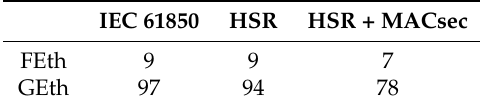
Table 3. Maximum number of nodes for different communication protection according to